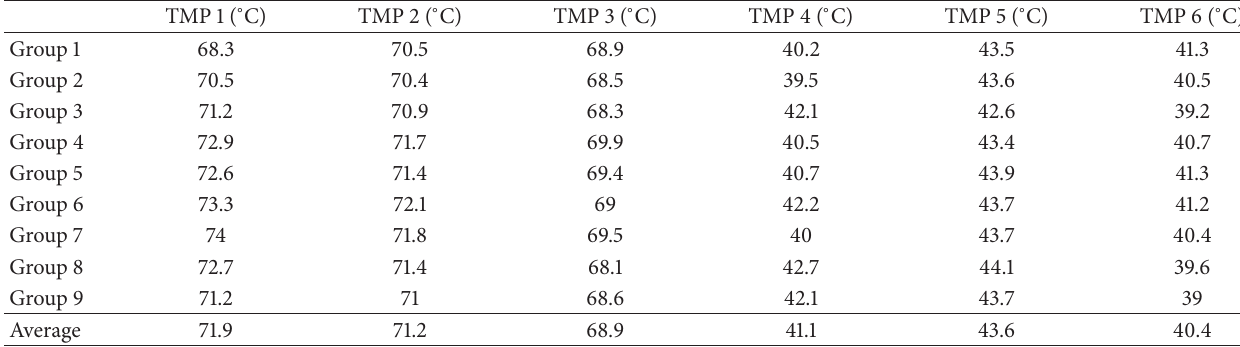
Table 2: Temperature test data of test specimens.